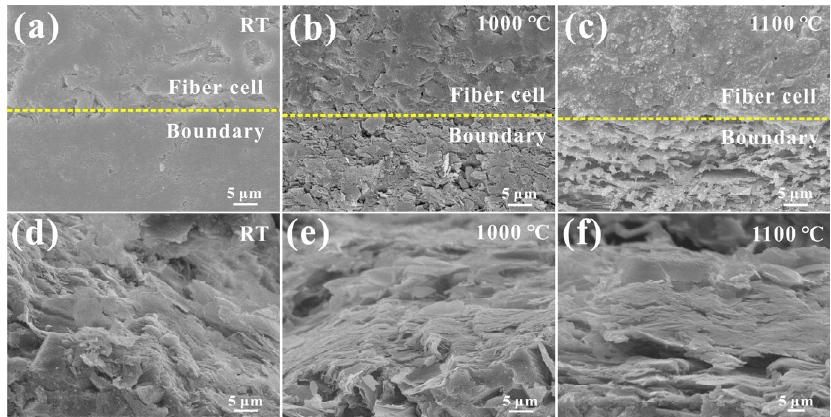
Fig. 8 (a–c) Surface morphologies and (d–f) internal fracture surface microstructures of the PcBN/hBN fibrous monolithic ceramics after mechanical tests at different